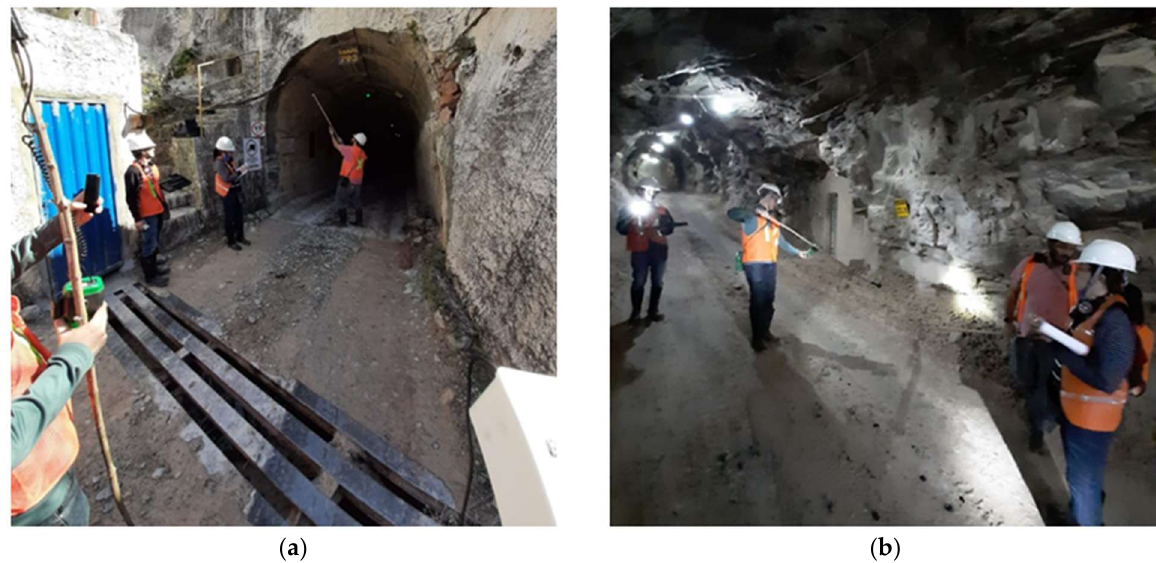
Figure 3. Measurements in underground mine performed by the research team (Minas Gerais State, Brazil). ( a ) Underground mine entrance. ( b ) Inside the underground mine.